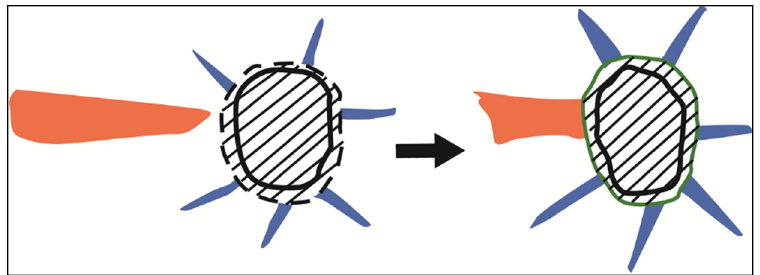
Figure 14. The schematic diagrams of crack propagation.